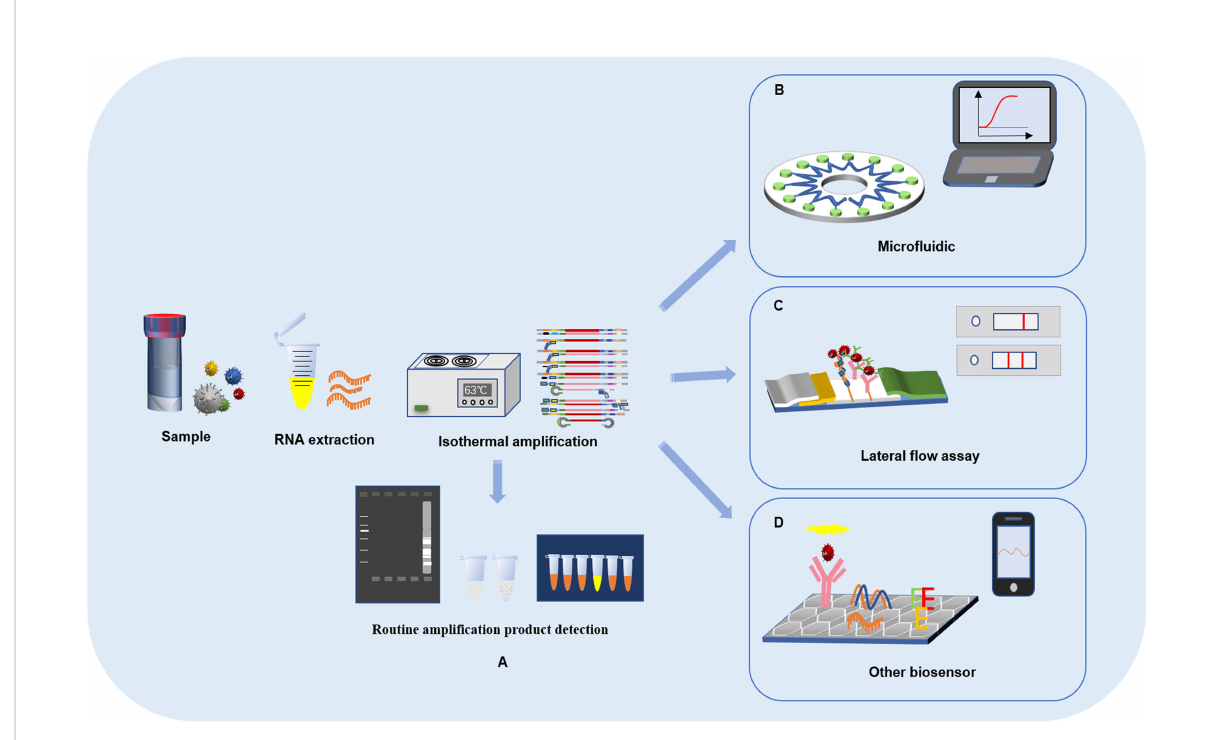
FIGURE 1 Loop-mediated isothermal ampli fi cation reaction process and detection of SARS-CoV-2 based on LAMP combined with biosensors. (A) LAMP reaction process and result readout. (B) SARS-CoV-2 detection based on LAMP combined with lateral fl ow assays. (C) SARS-CoV-2 detection based on LAMP combined with micro fl uidic chips. (D) SARS-CoV-2 detection based on LAMP combined with other